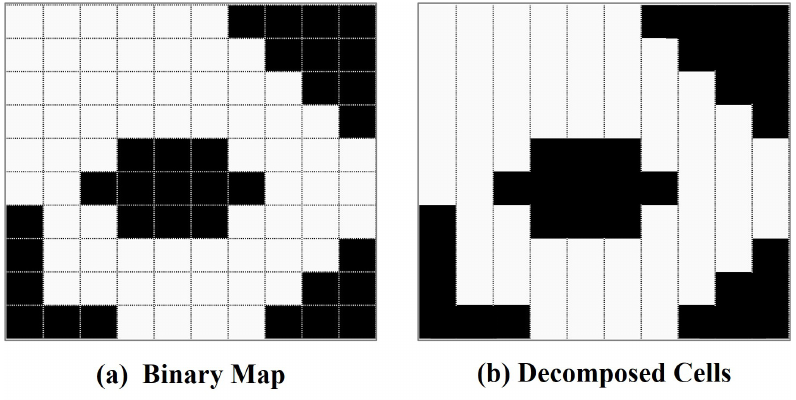
Figure 1. Decomposing the mission environment into cells.